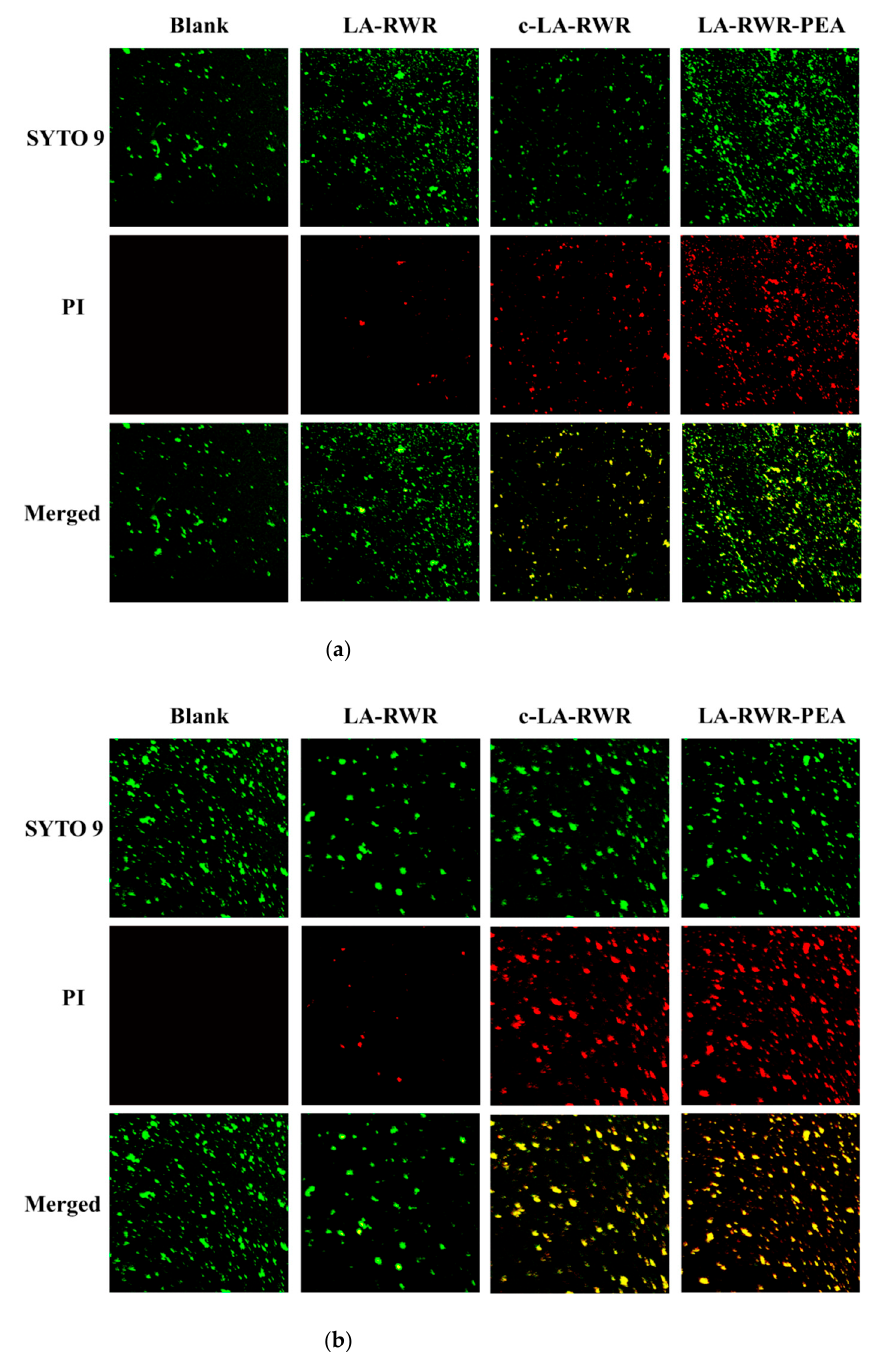
Figure 5. CLSM images of ( a ) E. coli and ( b ) S. aureus biofilms treated with LA ‐ RWR, c ‐ LA ‐ RWR nanoparticles, and LA ‐ RWR ‐ PEA at 2MIC concentration for 5 h, respectively.